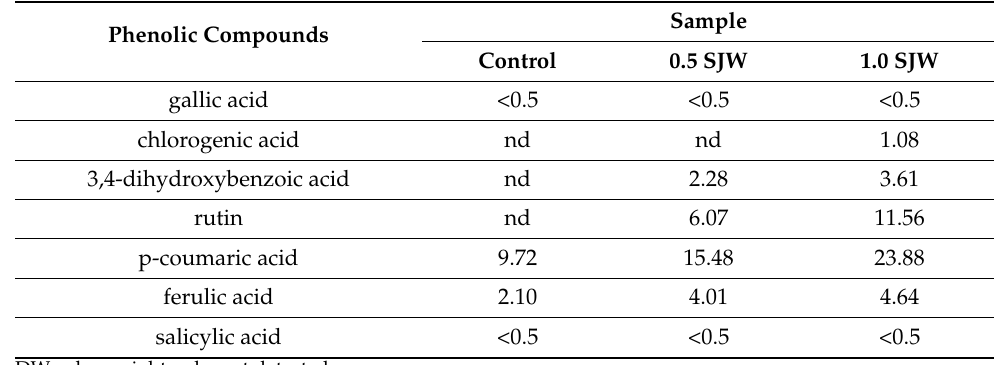
Table 6. Composition of phenolic compounds identified in fractions µ g g − 1 DW.